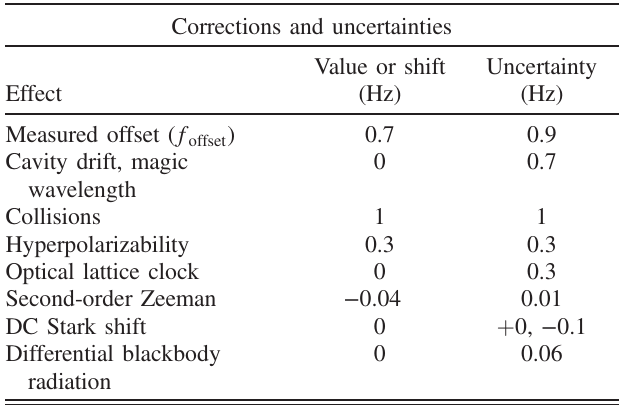
TABLE I. Summary of shifts and uncertainties in the frequency comparison measurements with the optical lattice